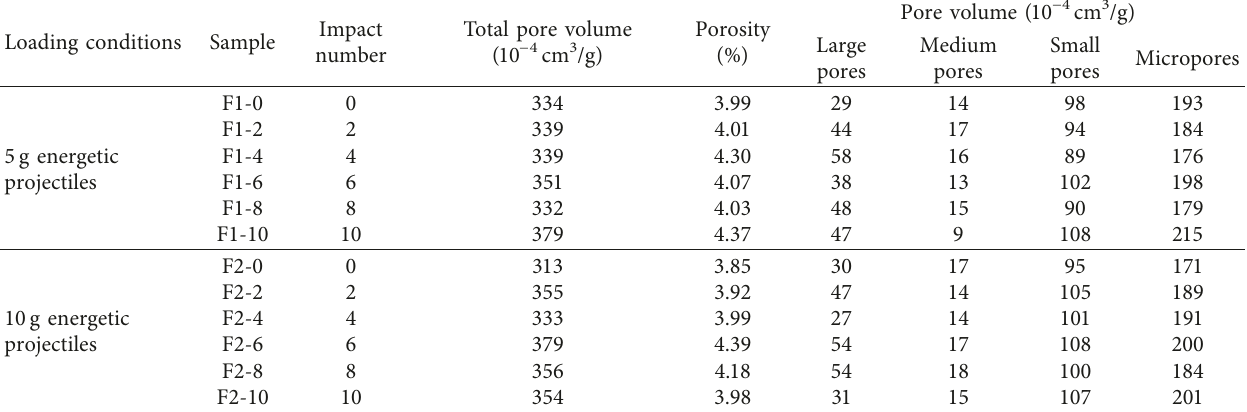
Figure 5: Development of macroscopic cracks: (a) F1; (b) F2; (c) F3. (A) Impact 0 times; (B) impact 2 times; (C) impact 6 times; (D) impact 8 Table 2: Pore structure parameters of fat coals by using mercury intrusion porosimetry.